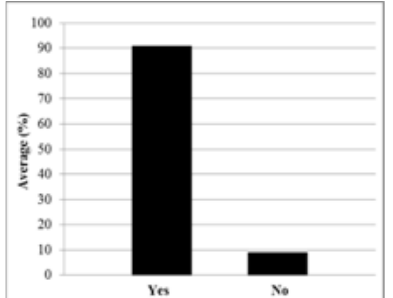
Figure 10. Responses from the Titration experimental group on whether the simulation helped them comprehend the presented concepts